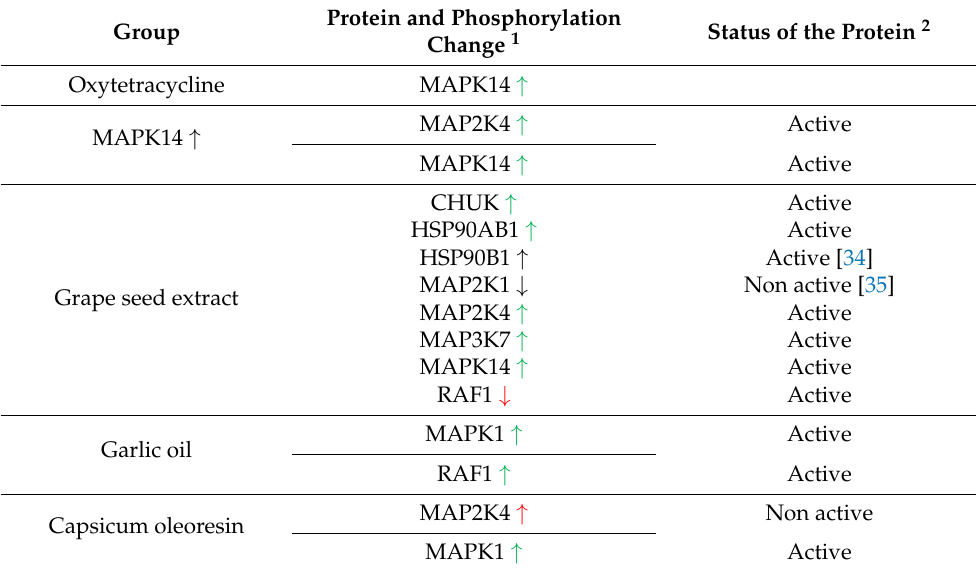
Figure 2. Section of Salmonella infection KEGG reference pathway (map05132) indicating the main phosphorylation changes of significant immune peptides ( p ≤ 0.05) of HD11 cells infected with S. Enteritidis and treated with gentamicin. Green squares indicate significantly activated protein; red squares indicate significantly deactivated protein; pink squares indicate either no site information was available or more sites of the same protein were significantly affected with both activation/deactivation of the protein. Adapted with permission from [33]. 2023, Kanehisa Laboratories. Table 4. Changes in the phosphorylation of significant immune peptides ( p ≤ 0.05) of HD11 cells infected with S. Enteritidis and treated with oxytetracycline or plant extracts.